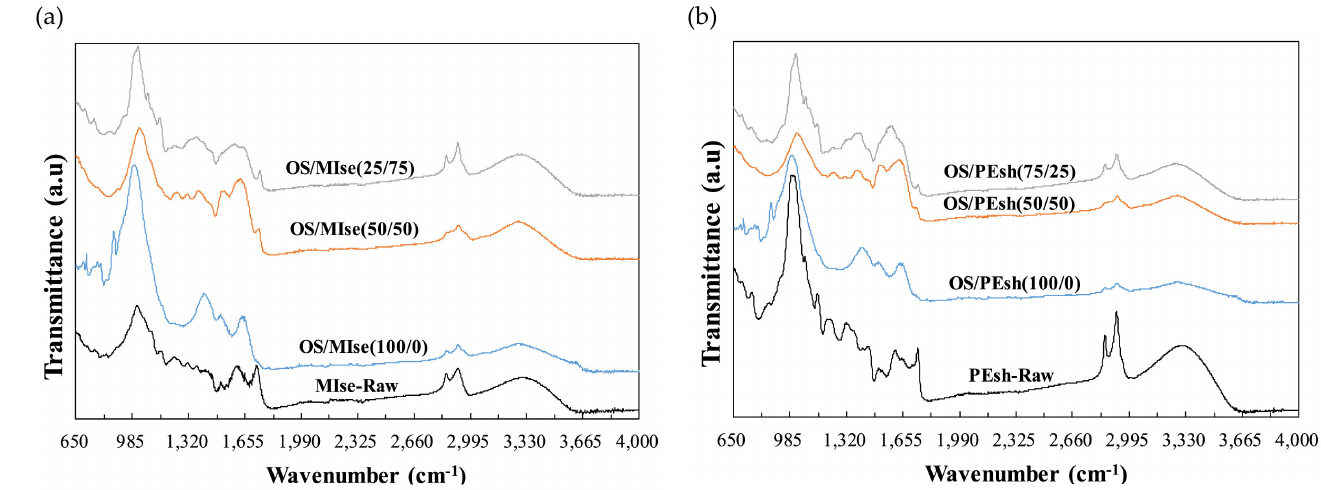
Figure 2. ( a ) Raw MIse and co-torrefied OS/MIse with different blended ratios; ( b ) raw PEsh and co- torrefied OS/PEsh with different blended ratios. Reprinted with permission from Ref. [46]. Copyright © 2021 Elsevier Ltd.